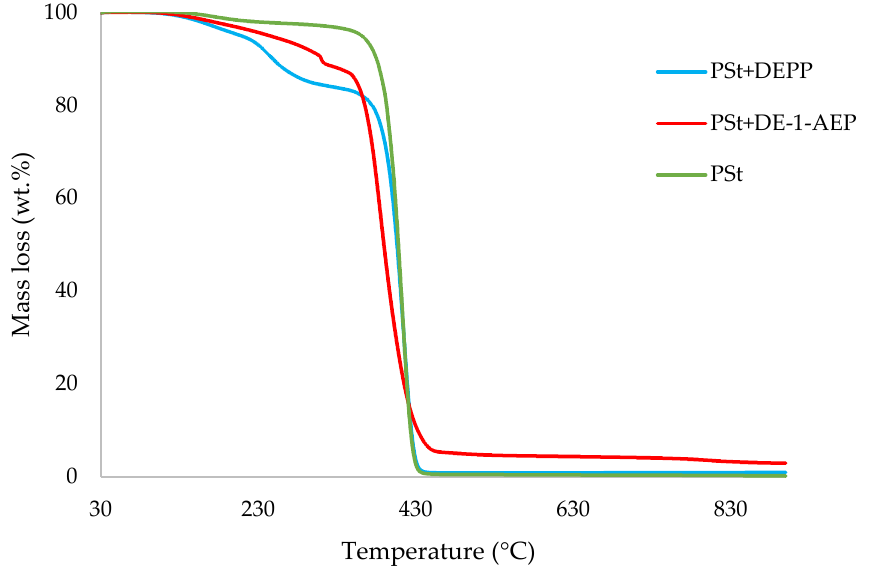
Figure 4. An overlay of the TGA curves of PSt and PSt+aliphatic phosphonate materials, at 10 °C min −1 in nitrogen, from 30 to 900 °C.